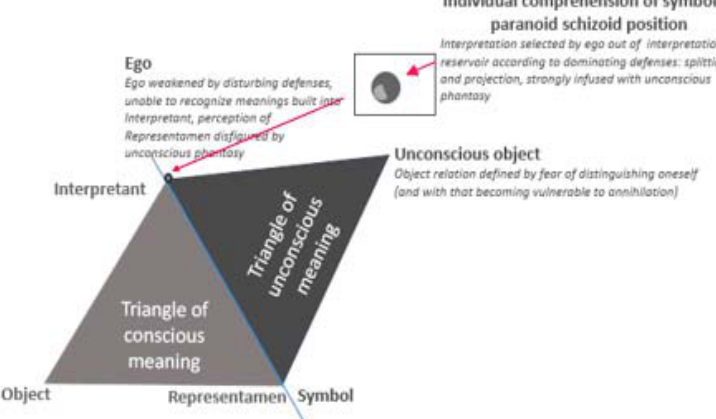
Figure 8. (cid:54)(cid:70)(cid:75)(cid:72)(cid:80)(cid:72)(cid:3)(cid:83)(cid:85)(cid:72)(cid:86)(cid:72)(cid:81)(cid:87)(cid:76)(cid:81)(cid:74)(cid:3)(cid:70)(cid:82)(cid:80)(cid:69)(cid:76)(cid:81)(cid:72)(cid:71)(cid:3)(cid:89)(cid:76)(cid:72)(cid:90)(cid:86)(cid:3)(cid:82)(cid:73)(cid:3)(cid:38)(cid:75)(cid:68)(cid:85)(cid:79)(cid:72)(cid:86)(cid:3)(cid:51)(cid:72)(cid:76)(cid:85)(cid:70)(cid:72)(cid:3)(cid:11)(cid:51)(cid:72)(cid:76)(cid:85)(cid:70)(cid:72)(cid:15)(cid:3)(cid:20)(cid:28)(cid:19)(cid:25)(cid:15)(cid:3)(cid:20)(cid:28)(cid:28)(cid:27)(cid:12)(cid:15)(cid:3)(cid:68)(cid:81)(cid:71)(cid:3) (cid:48)(cid:72)(cid:79)(cid:68)(cid:81)(cid:76)(cid:72)(cid:3)(cid:46)(cid:79)(cid:72)(cid:76)(cid:81)(cid:3)(cid:11)(cid:46)(cid:79)(cid:72)(cid:76)(cid:81)(cid:15)(cid:3)(cid:20)(cid:28)(cid:22)(cid:19)(cid:15)(cid:3)(cid:20)(cid:28)(cid:23)(cid:27)(cid:12)(cid:3)(cid:82)(cid:81)(cid:3)(cid:86)(cid:92)(cid:80)(cid:69)(cid:82)(cid:79)(cid:15)(cid:3)(cid:90)(cid:75)(cid:72)(cid:81)(cid:3)(cid:83)(cid:68)(cid:85)(cid:68)(cid:81)(cid:82)(cid:76)(cid:71)(cid:16)(cid:86)(cid:70)(cid:75)(cid:76)(cid:93)(cid:82)(cid:76)(cid:71)(cid:3)(cid:83)(cid:82)(cid:86)(cid:76)(cid:87)(cid:76)(cid:82)(cid:81)(cid:3)(cid:73)(cid:85)(cid:68)(cid:80)(cid:72)(cid:86)(cid:3)